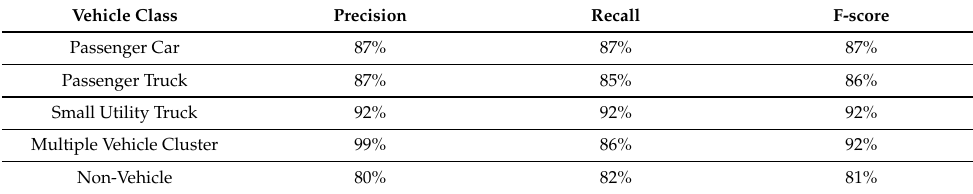
Table 11. Different evaluation metrics for the detected classes within Video 2.